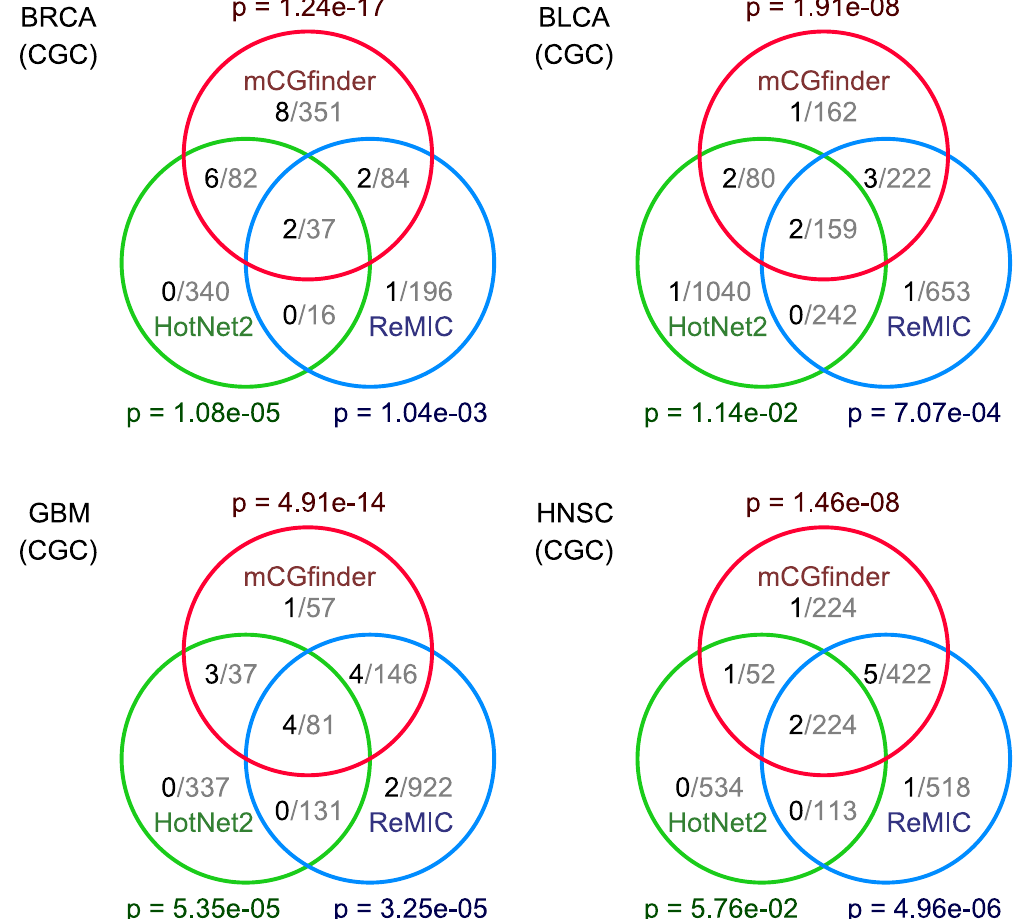
Figure 2. Venn diagrams of intersections between the genes detected by mCGfinder (red circle), HotNet2 (green circle) and ReMIC (blue circle) on TCGA somatic mutation datasets of BRCA (north-west panel), BLCA (north-east panel), GBM (south-west panel) and HNSC (south-east panel). The gray and black numbers in each region of the Venn diagrams indicate the number of detected genes and the number of genes also reported in Cancer Gene Census (CGC) 46 respectively. The p-values next to the circles of the methods are calculated by Fisher’s exact test, representing the enrichment significance of the detection results for CGC annotated cancer